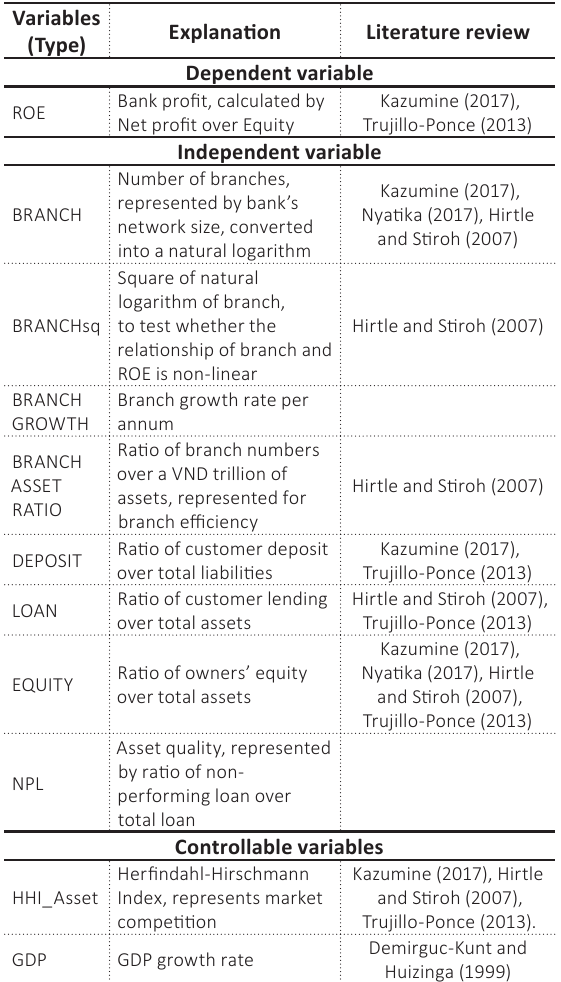
Table 1. Summary of